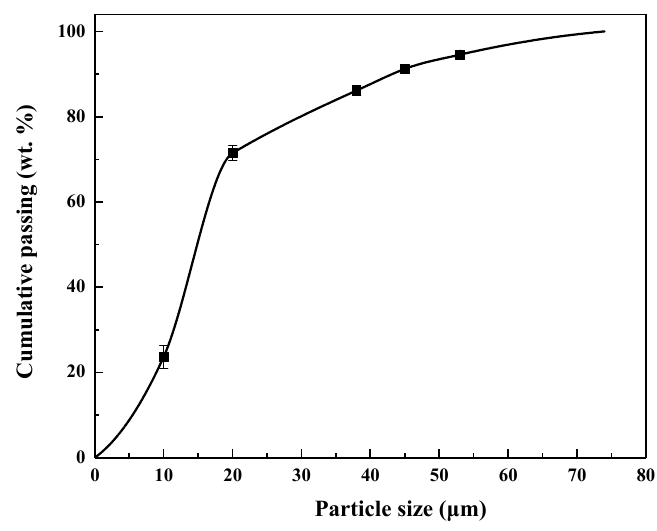
Figure 1. Particle size distribution of coke powder used in this study.